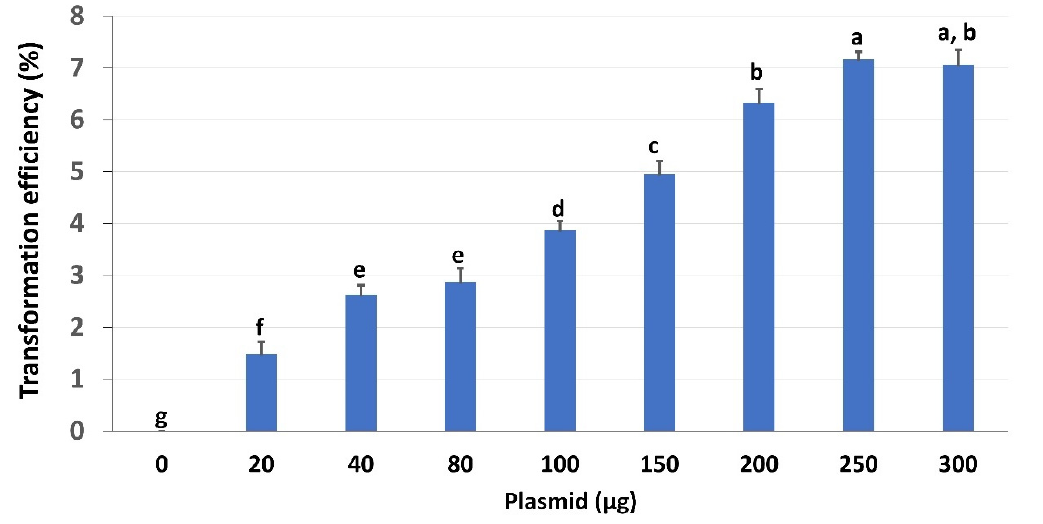
Figure 4. Effects of plasmid concentrations on protoplast transfection: The transformation efficiency of protoplasts cultivated with various concentrations of plasmids. The protoplast was evaluated after incubation in 50% PEG solution for 10 min. Values represent means ± SE ( n = 7). The different letters indicate significant differences at p < 0.05.